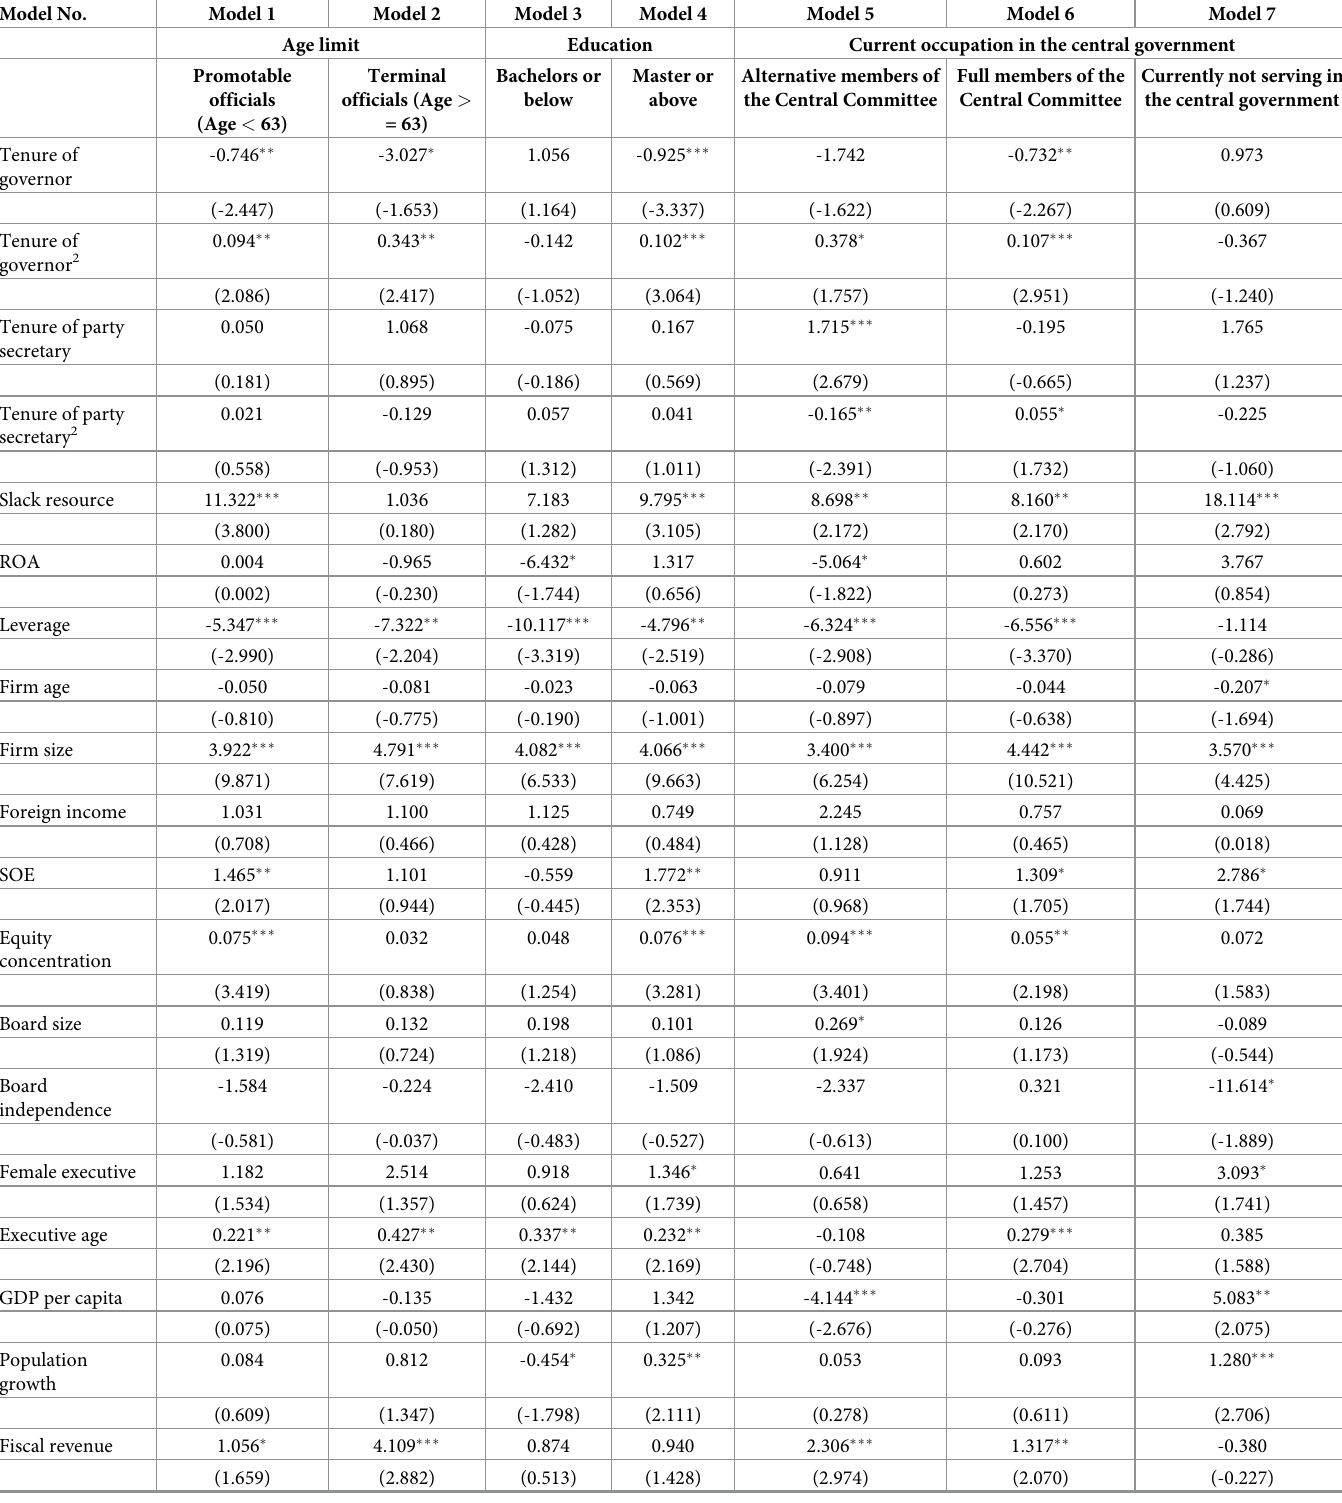
Table 9. The effect of governors’ personal characteristics. Model